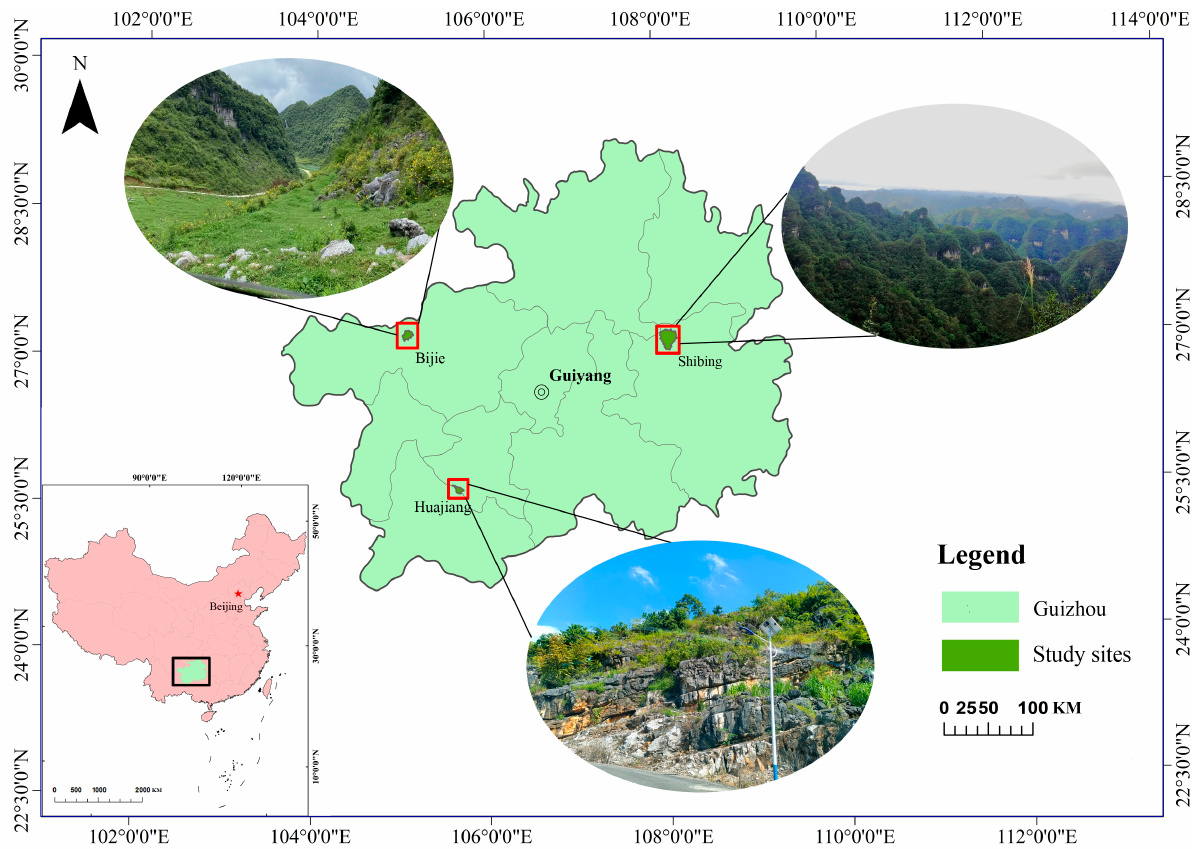
Figure 1. Map showing the locations of the study areas.